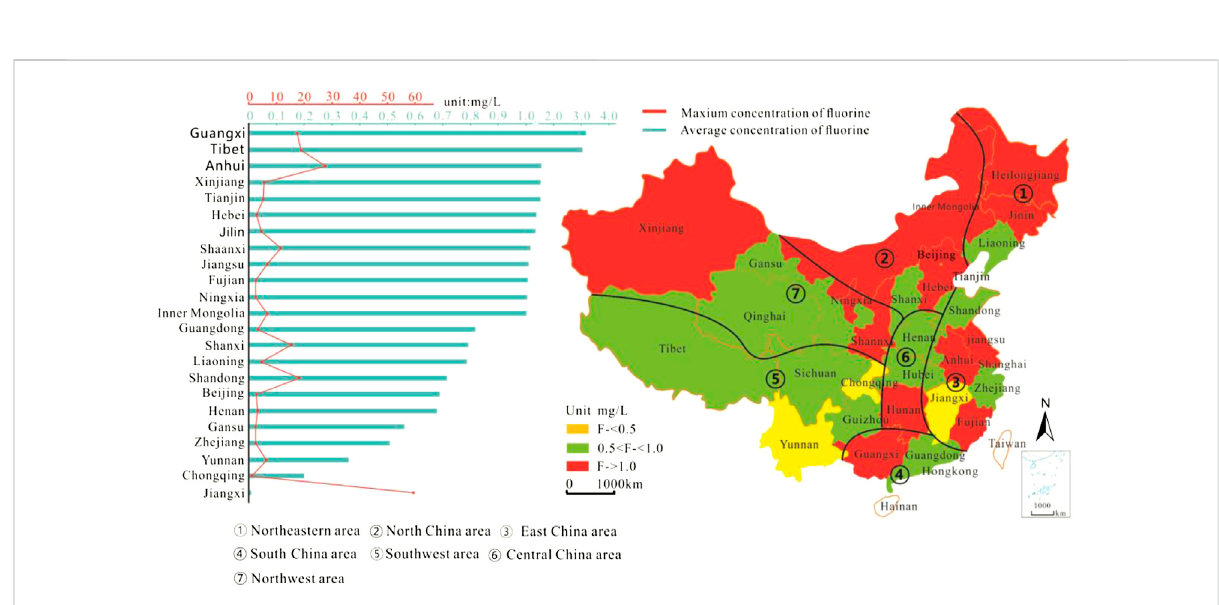
FIGURE 2 Average fl uoride content in shallow groundwater in various provinces in